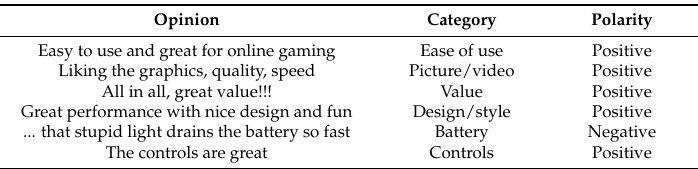
Table 1. ABSA (aspect-based sentiment analysis) identifies the aspects of the entities and the sentiments expressed for